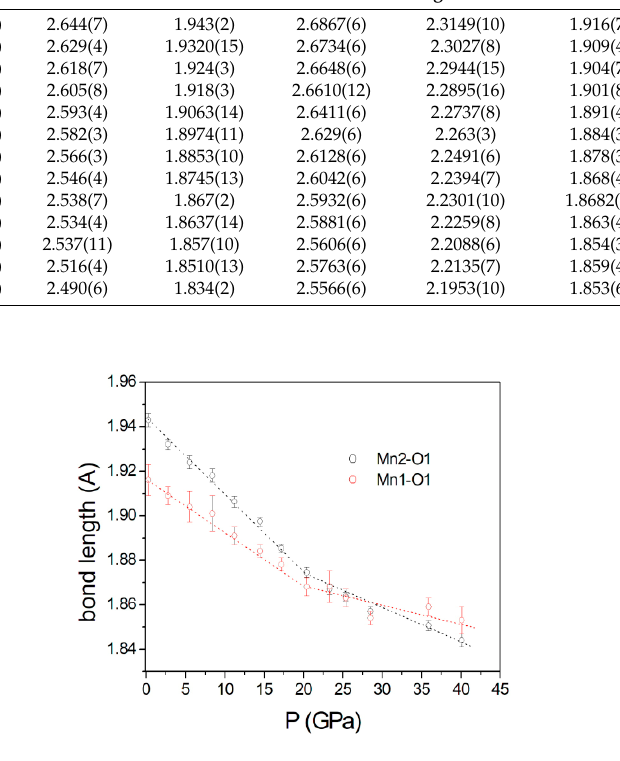
Figure 7. Pressure dependence of the manganese-oxygen bond lengths. A slope change is observed at 18 GPa, where the Mn1-O1 ≅ Mn2-O1 bonds.